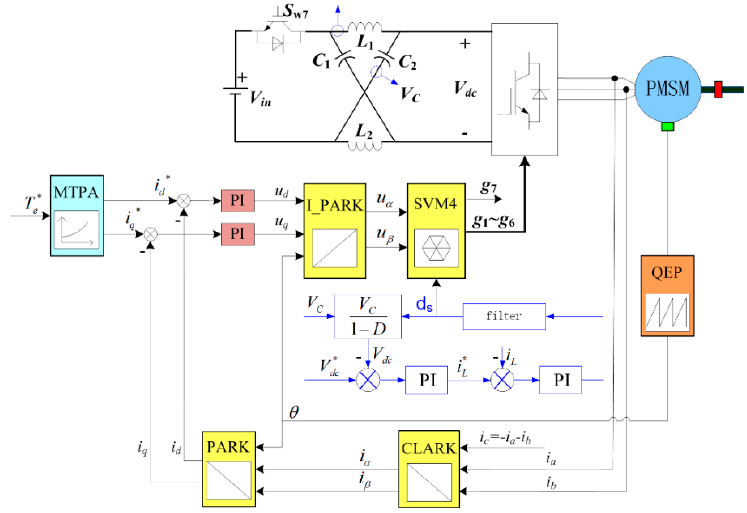
Figure 2. Control block diagram of Z-Source drive PMSM system.